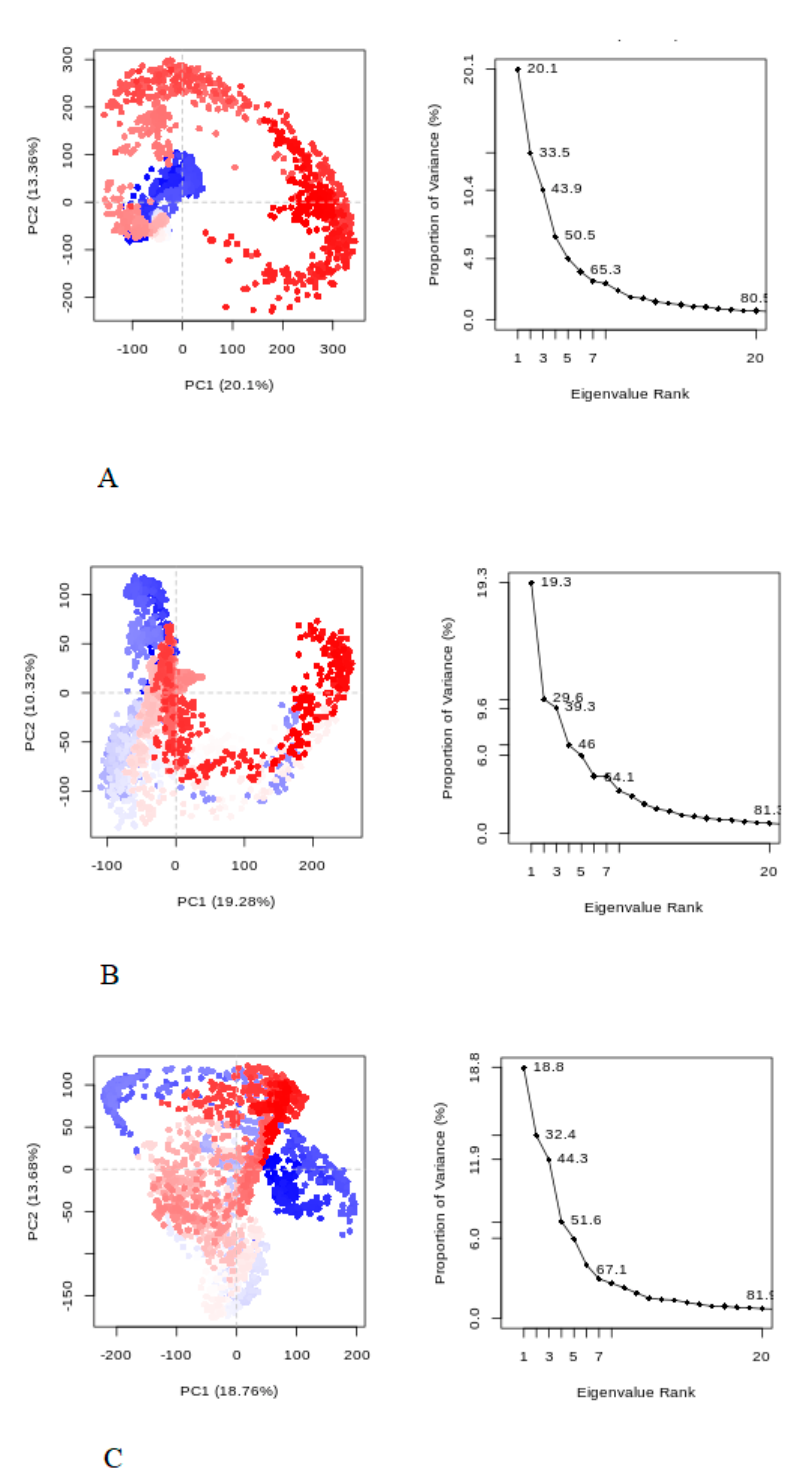
Figure 5. Principalcomponentanalysis( A )hexaconazole,( B )dihydrotestosterone,and( C Figure 5. Principal component analysis ( A ) hexaconazole, ( B ) dihydrotestosterone, and ( C ) amino- glutethimide.